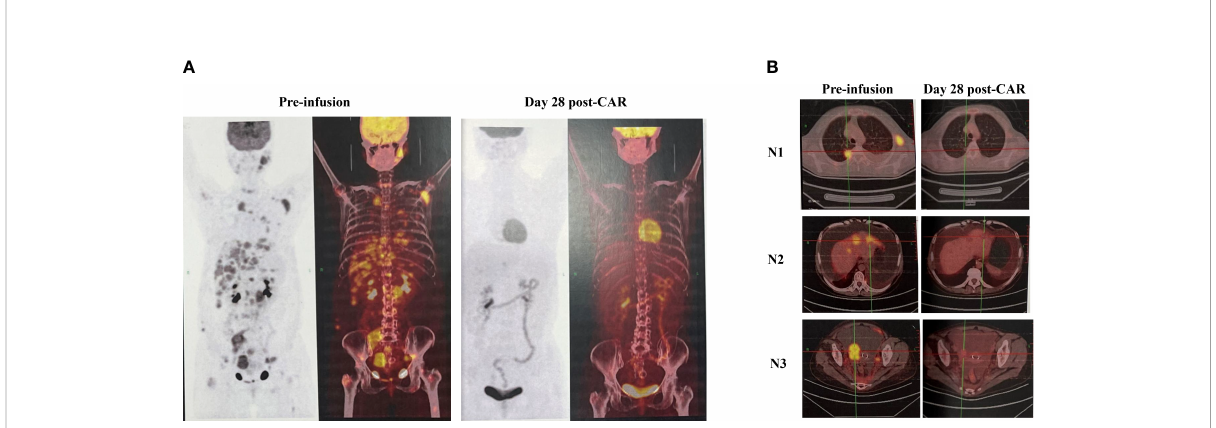
FIGURE 1 Clinical evaluation by PET-CT imaging. (A) Compared with the image before CAR T, PET-CT evaluation on day 28 showed nearly CMR with a few loci in the liver left. (B) The lymphoma activities were inhibited after CAR T cell infusion, as seen by PET-CT images for nodules at the lung, liver, and right adnexa. CMR, complete metabolic remission; N,